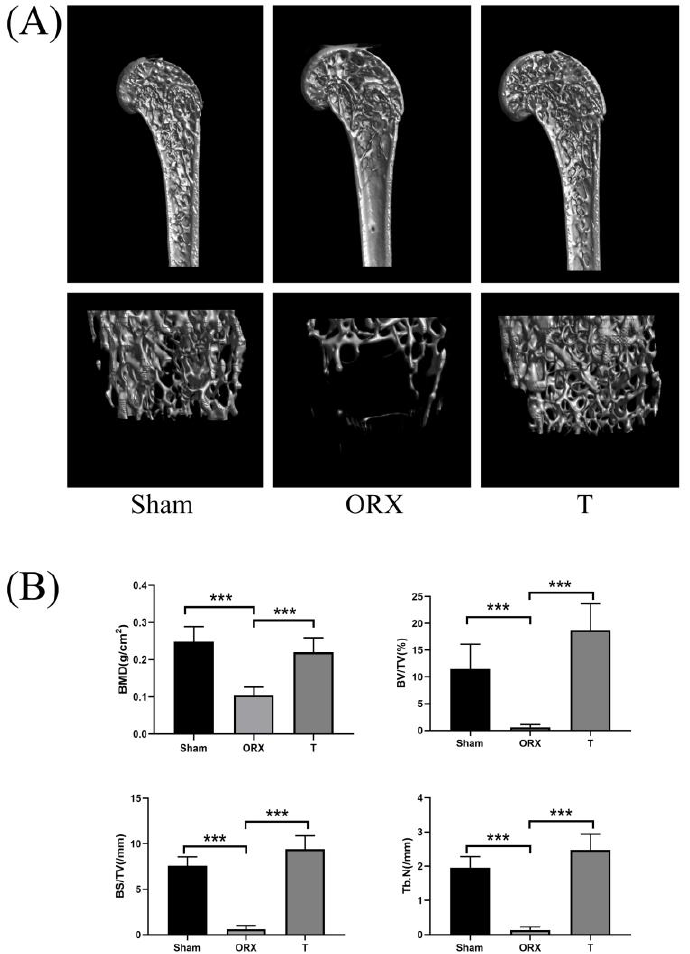
Figure 1. Testosterone (T) prevents bone loss in orchiectomy (ORX) mice in vivo. ( A ) Representative 3D micro-CT reconstructions of mouse femurs from sham (PBS injection), ORX (PBS injection), and T (ORX with 12.5mg/kg testosterone). ( B ) Quantitative bone morphometric parameters of bone mineral density (BMD, g/cm 2 ), bone volume to total tissue volume (BV/TV), bone surface to tissue volume (BS/TV, mm − 1 ), and trabecular number (Tb.N., mm − 1 ) were measured. Values presented as the mean ± standard deviation (n = 3). ***: p < 0.001.